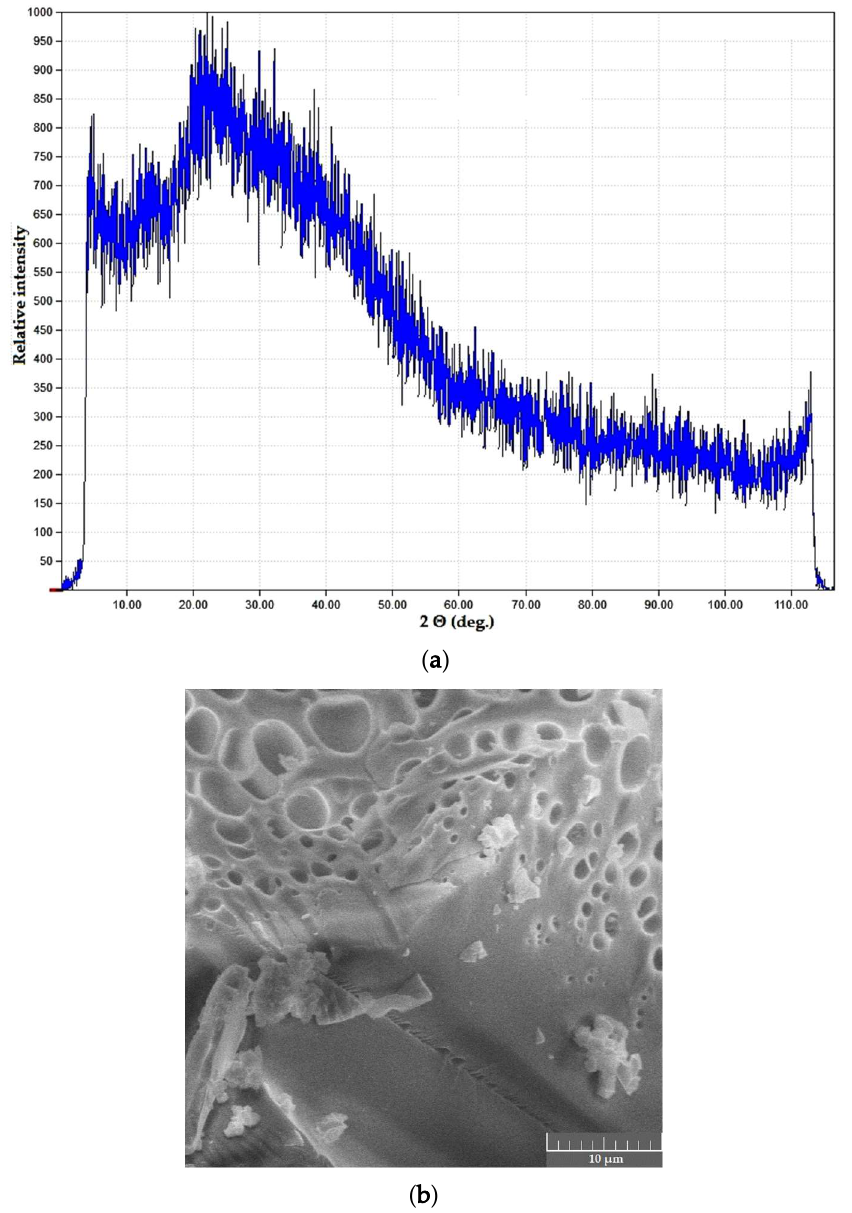
Figure 10. Dried products in the PVP–CAY system: (a) phase composition; (b) microstructure.